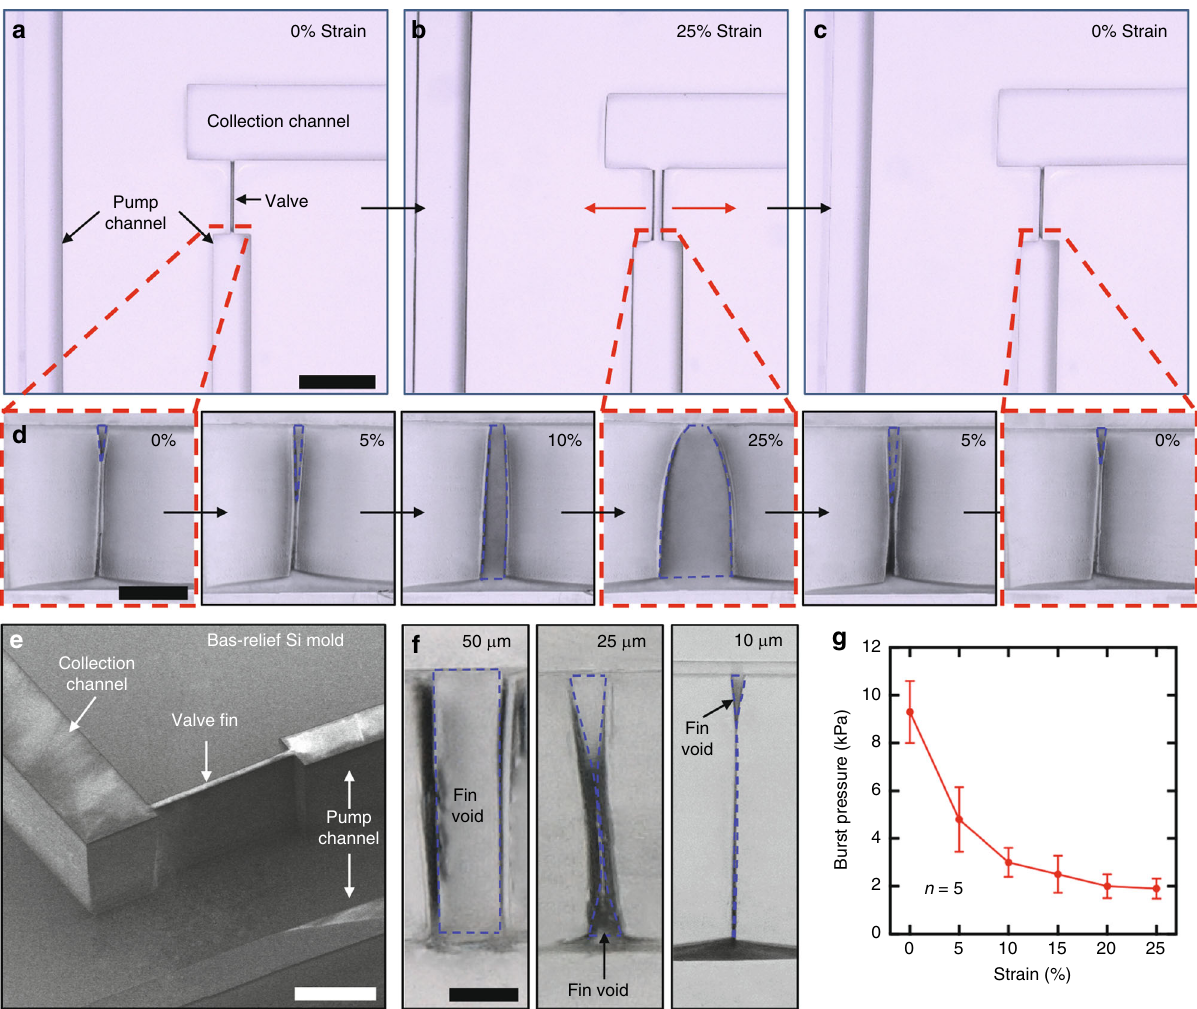
Fig. 3 Elastomeric, strain-actuated pinch valve. The mechanically actuated opening and reversible collapse of high-aspect ratio voids in molded elastomers form the basis of strain-actuated pinch valves. a Top view of a soft, micro fl uidic pinch valve shortly after lamination with the capping layer to complete the assembly of the device structure. Scale bar: 500 µ m. b Strain applied perpendicular to the valve overcomes van der Waal forces between the sidewalls of the elastomer to open the valve. c Relaxing the strain reforms of the adhesive bond between the walls. d Cross-sectional micrographs of a valve with an as- fabricated width of 10 µ m and height of 250 µ m for strains between 0% and 25%. Scale bar: 100 µ m. e Scanning electron micrograph of the corresponding silicon mold, illustrating the fi n structure used to de fi ne the valve. Scale bar: 250 µ m. f Cross-sectional micrographs of PDMS valve sidewalls formed from silicon fi ns with widths of 50 µ m (left), 25 µ m (middle), and 10 µ m (right). Scale bar: 50 µ m. g Burst pressure of valves formed from 10 µ m wide fi ns for strains of up to 25%. The error bars indicate standard